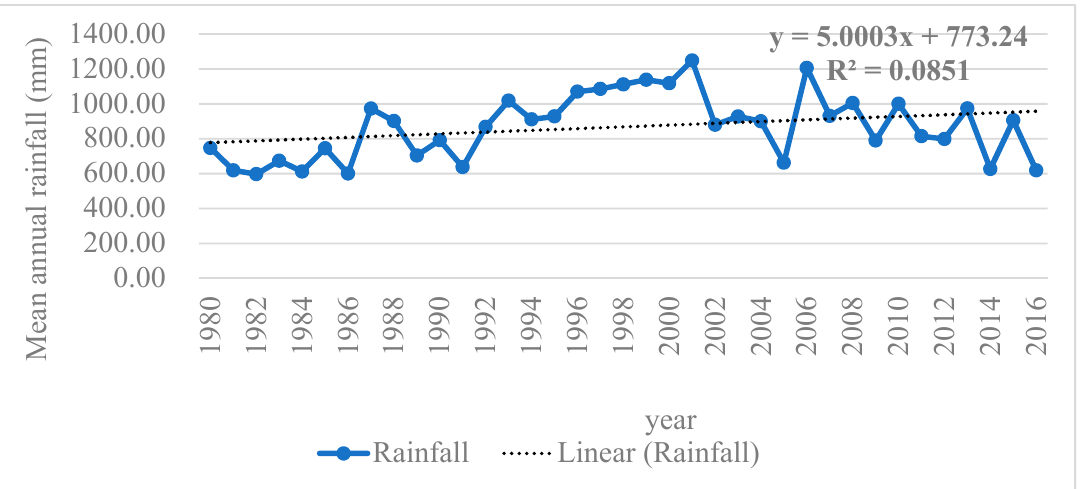
Figure 2. Annual mean precipitation of the study region (1980–2016).